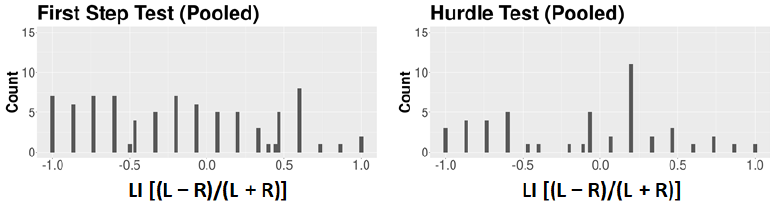
Figure A3. Frequency distribution of the dogs’ LI data for all the pooled First Step and the pooled Hurdle Test.